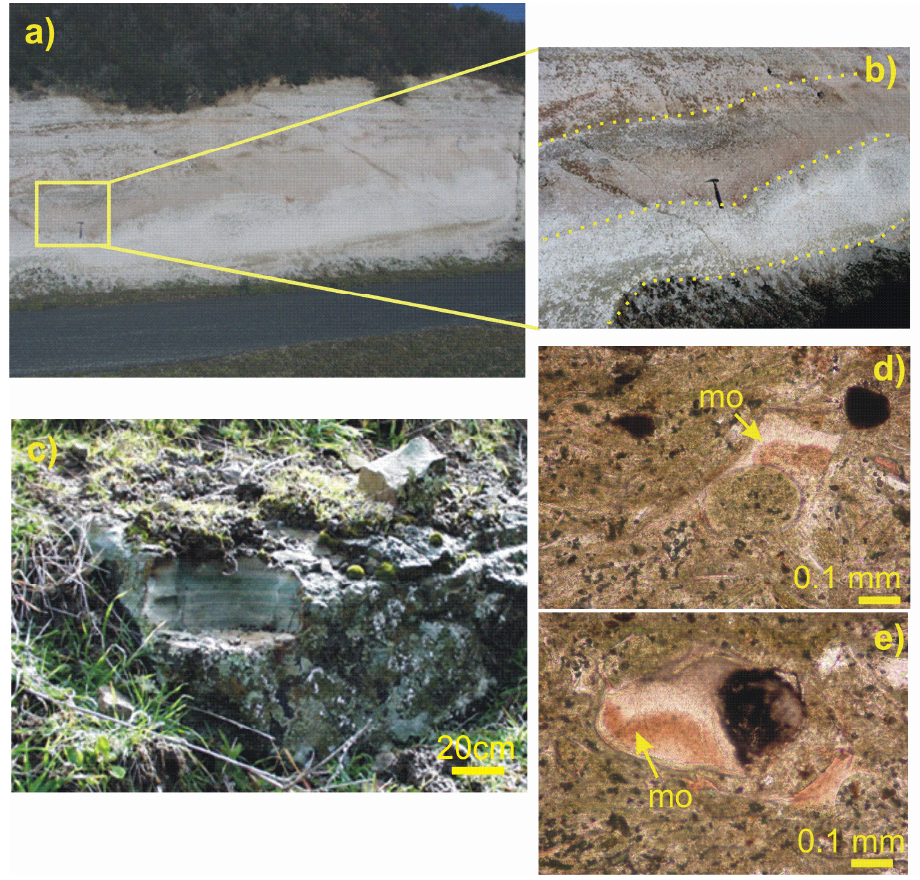
Figure 3. The Asuni Unit: ( a ) and ( b ) interbedded whitish and laminar ashy-to-sandy deposits (F sequence in Figure 2); ( c ) typical outcrop showing greenish layering (I sequence in Figure 2); ( d ) and ( e ) photomicrographs obtained under plane-polarized transmitted light showing the altered ashy-to-sandy matrix and widespread mordenite.